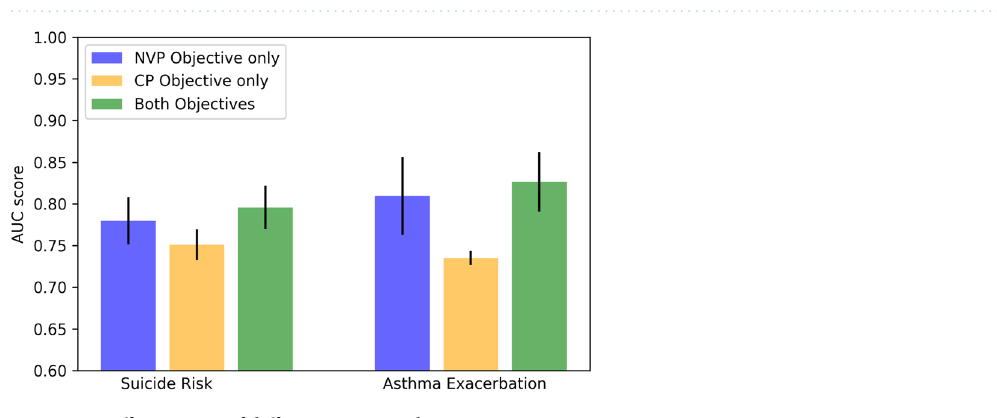
Figure 9. Effectiveness of different training